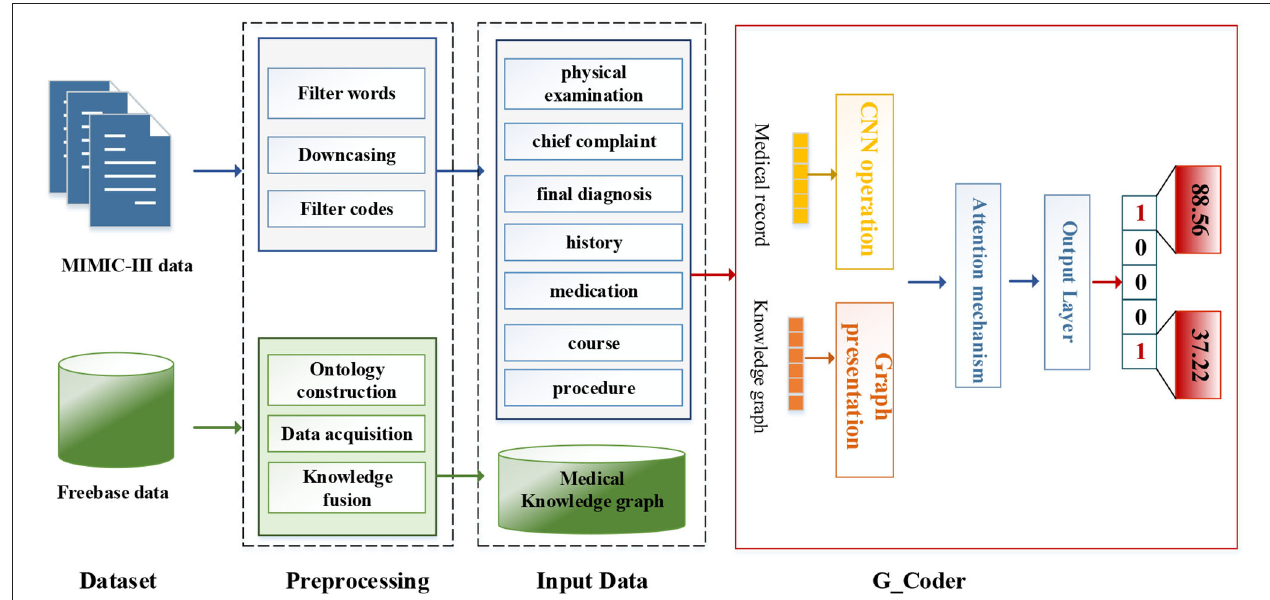
FIGURE 1 | The overall process of this method.